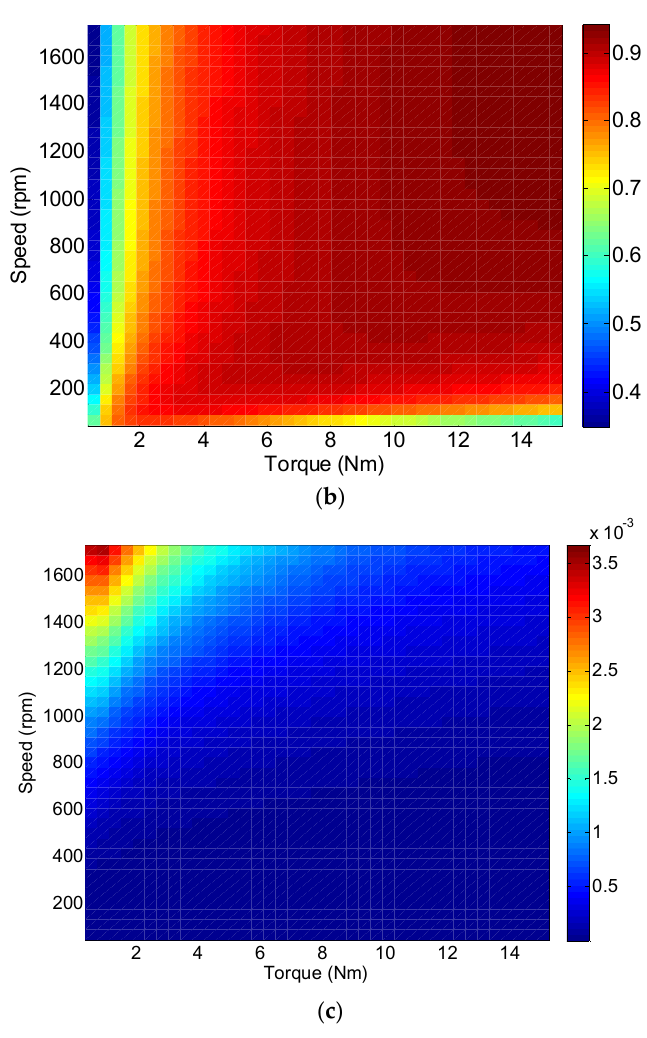
Figure 11. Results of the PMSM in SPWM: ( a ) Efficiency of PMSM in traditional i d = 0 control; ( b ) Efficiency of PMSM in proposed MEPT control; ( c ) Difference of efficiency between i d = 0 control and MEPT control.